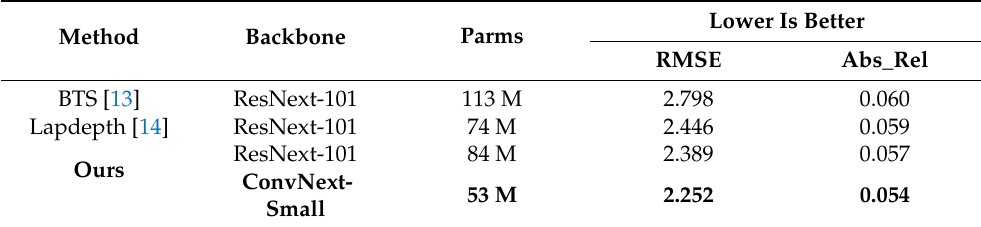
Table 6. KITTI Eigen split performance comparison with BTS and Lapdepth using the same back- bone network.